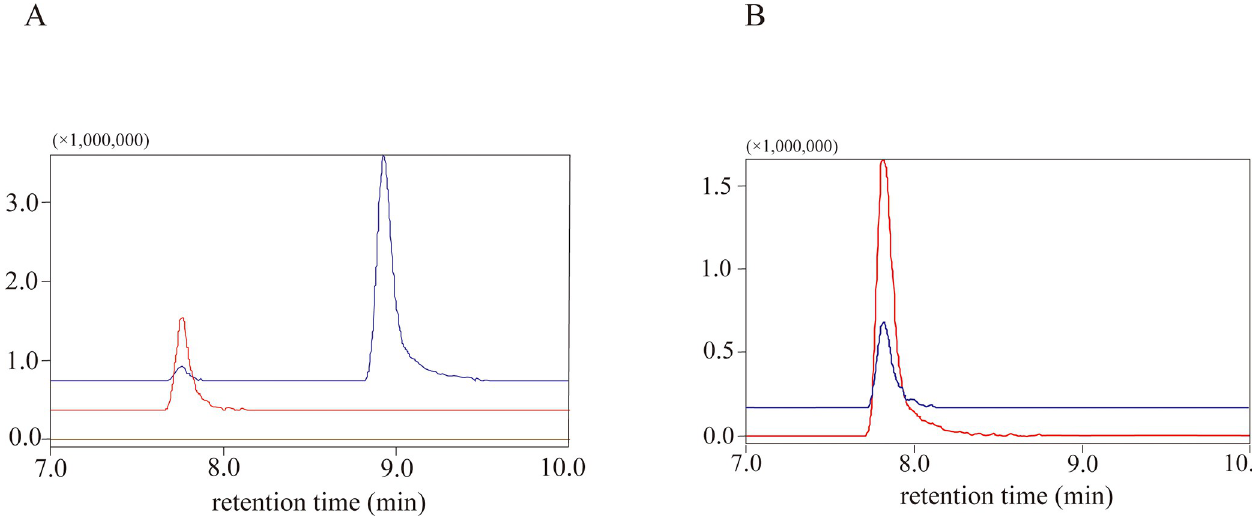
Fig 4. Analysis of reaction products of sw SULT ST3 using liquid-chromatography-tandem mass spectrometry (LC-MS/MS). Mass chromatograms are shown on selective mass traces at m/z 269.0450 (blue), m/z 349.0018 (magenta) and m/z 428.9256 (brown). The reaction mixture after incubation of genistein with sw SULT ST3 and PAPS (A) and genistein-7-sulfate standard (B) were loaded onto LC-MS/MS. Chromatographic conditions are described in the Methods section. Genistein, the reaction product, and genistein-7-sulfate are indicated by an arrow.